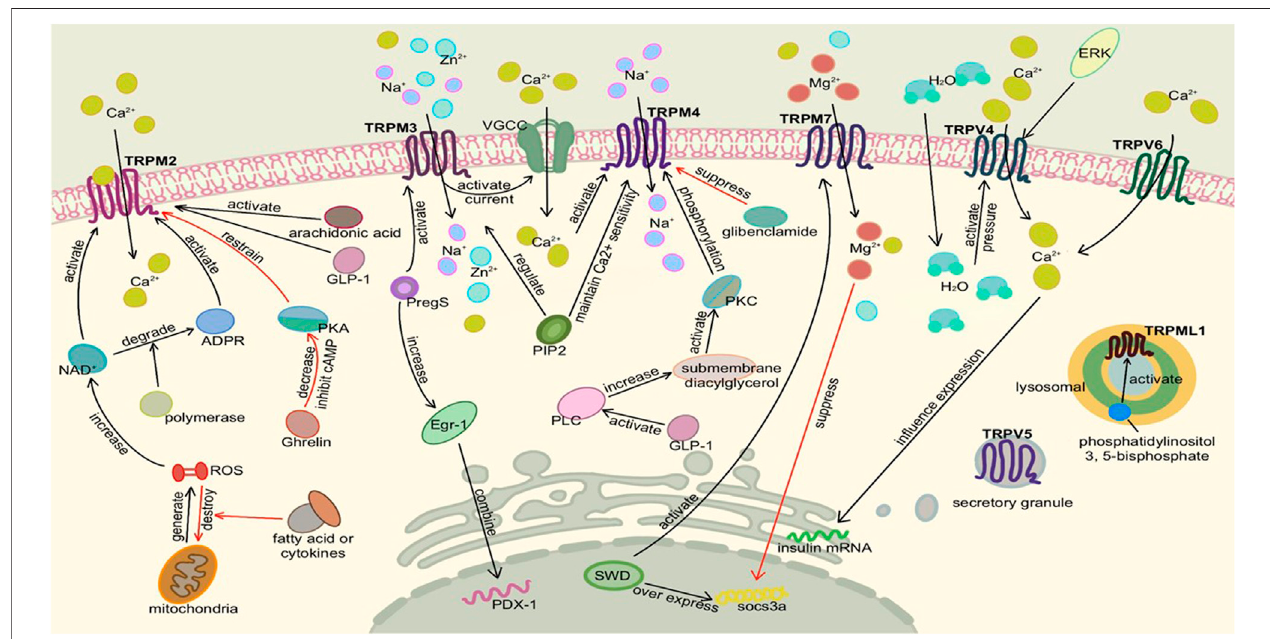
FIGURE 3 | Activation of TRP channels in thepancreas Ⅱ . Here is pancreatic β cell or adenomacell. TRPM2, TRPM3, TRPM4, and TRPM7 are also activated to promote insulinsecretion.ItisnoteworthythatTRPM2needstobindtoCa 2+ ,TRPM3mainlymediatesNa + andZn 2+ in fl ux,TRPM4mainlymediatesNa + in fl ux,andTRPM7mediatesMg 2+ in fl ux. They mainly mediate extracellular Ca 2+ in fl ux by changing membrane potential and activating voltage-gated calcium channels. Similar to TRPV2, TRPV4 was activated by osmotic pressure under high glucose conditions. Although TRPV6 exists in INS-1 and inhibits insulin mRNA expression, it does not affect insulin secretion